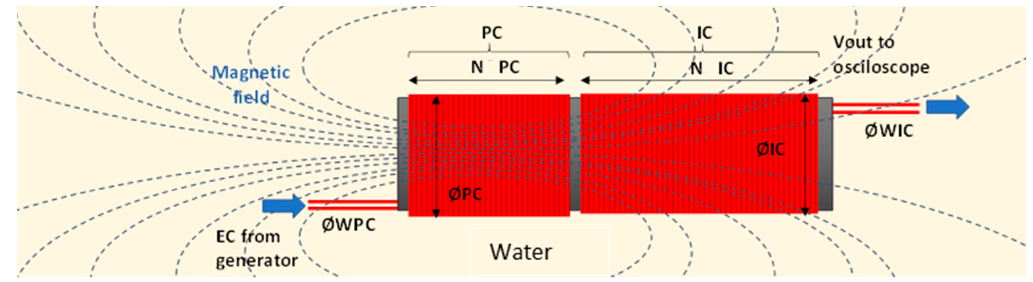
Figure 1. Presentation of the operation and variables of an induction coil in an aqueous medium.